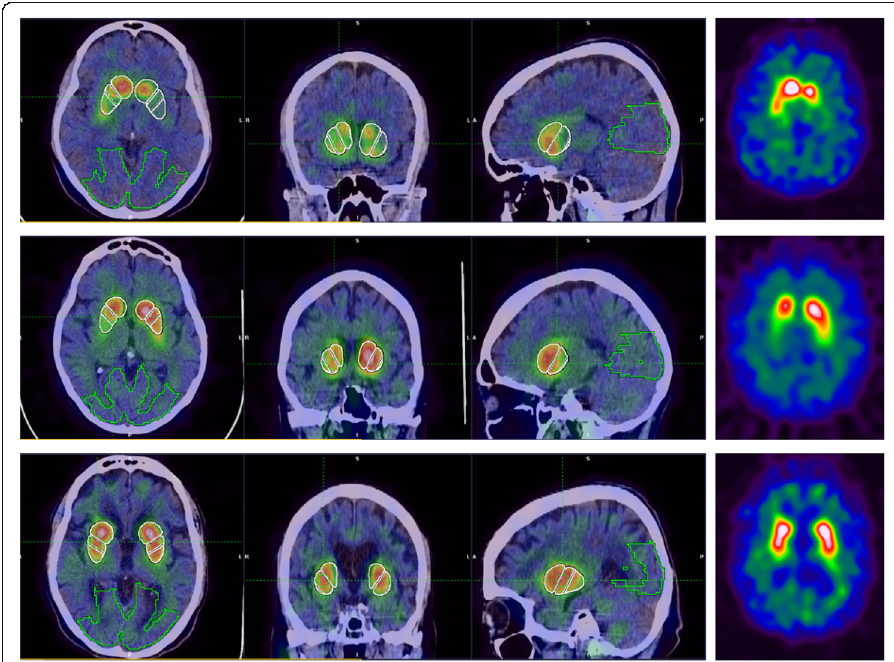
Fig. 8 Examples of three test cases used to validate the generated databases: two positive (first and second rows) and one negative (third row) case. Each row from left to right, axial, sagittal, and coronal fused view of the the patient ’ s SPECT and CT images showing the striatal and occipital VOIs, and the corresponding slab view images (Buchert et al. 2016b) generated within the syngo .via® software and used for